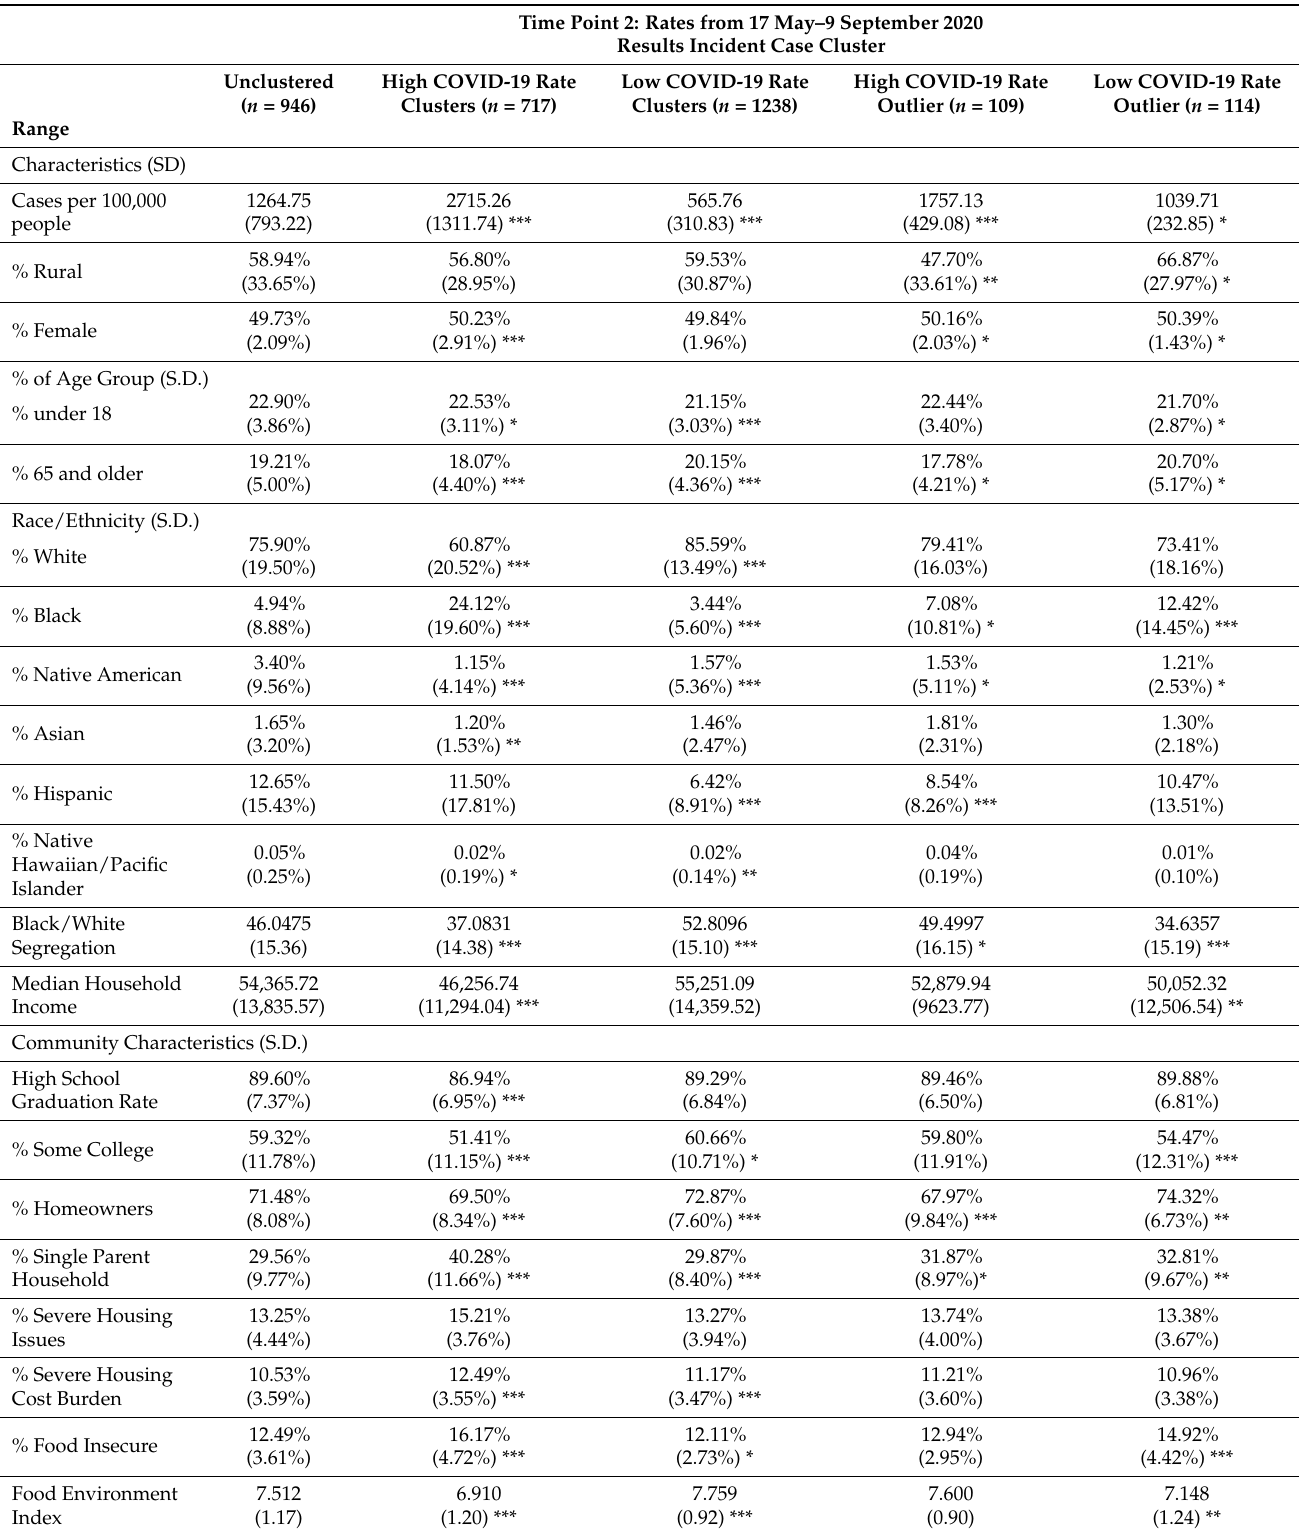
Table 2. County characteristics based on Anselin Moran’s I results for Time Point